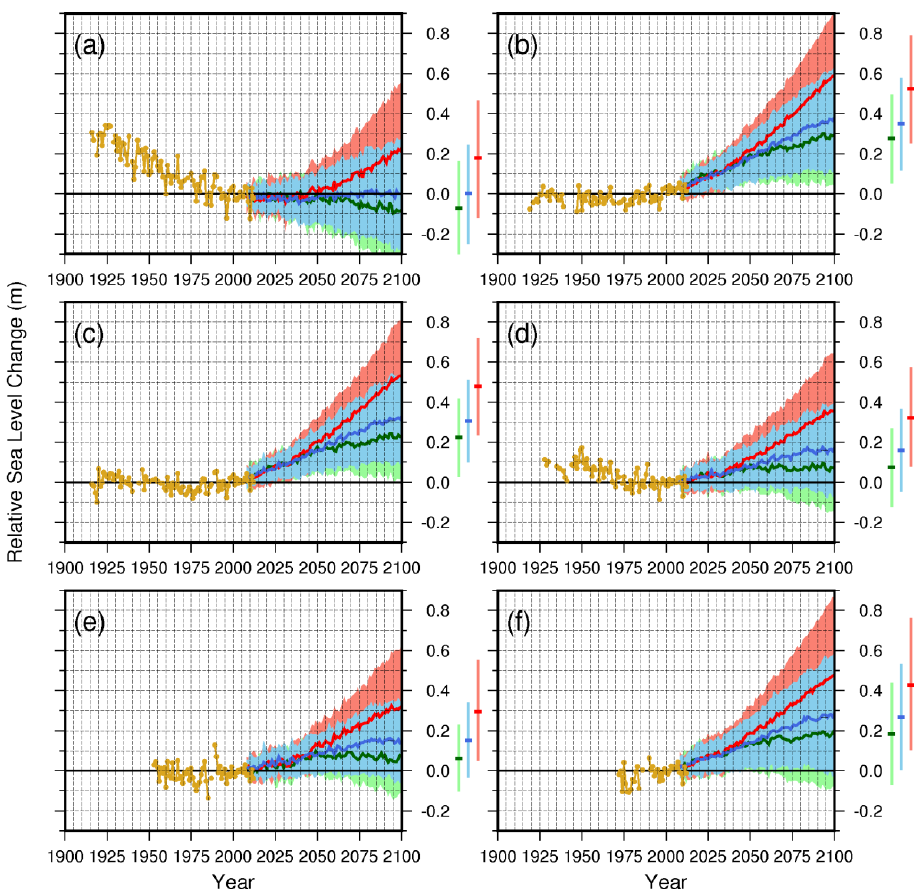
Figure 10. Relative sea-level projections for RCP2.6 (green), RCP4.5 (blue) and RCP8.5 (red) for the six key locations: ( a ) Oslo; ( b ) Stavanger; ( c ) Bergen; ( d ) Heimsjø; ( e ) Tromsø; and ( f ) Honningsvåg. The vertical bars on the right side of the panels represent the ensemble mean and ensemble spread (5% to 95%) for RSL change for 2081–2100. Annual mean tide gauge observations are shown in